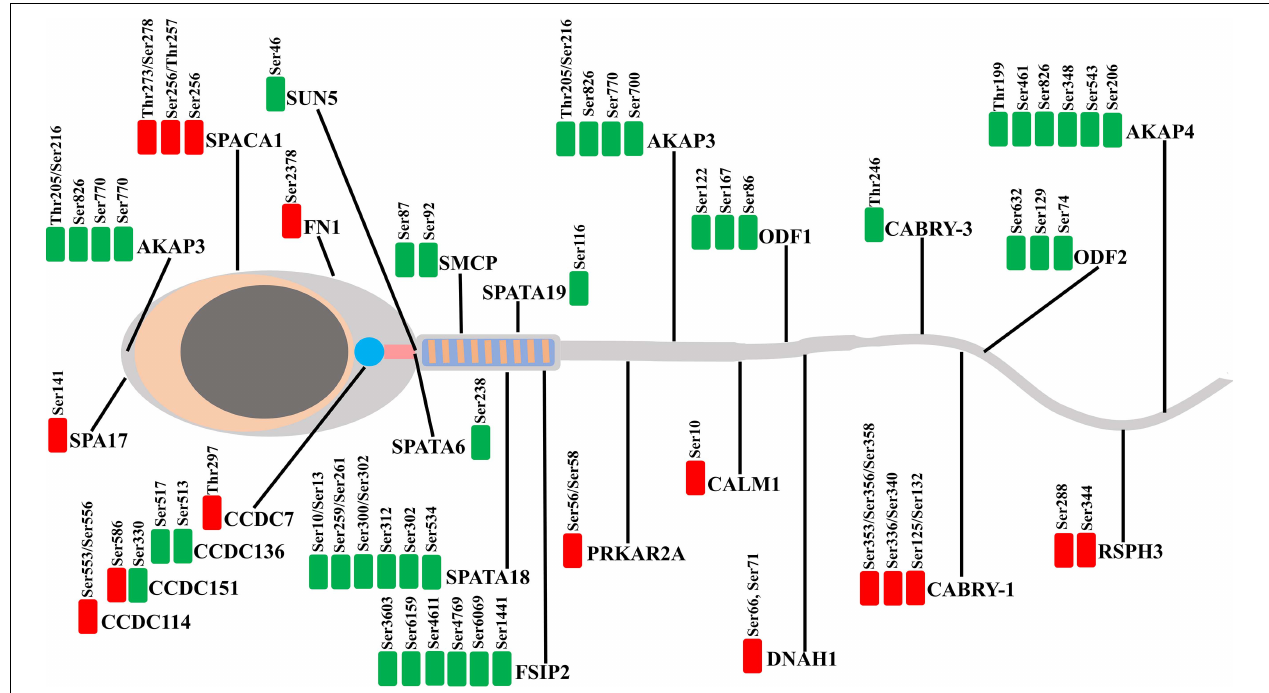
FIGURE 7 | Illustration gathering the localization of the proteins belonging to the DEPPs between Yorkshire and Duroc boar spermatozoa. The downregulated and upregulated phosphorylated sites shown in the green and red plots,